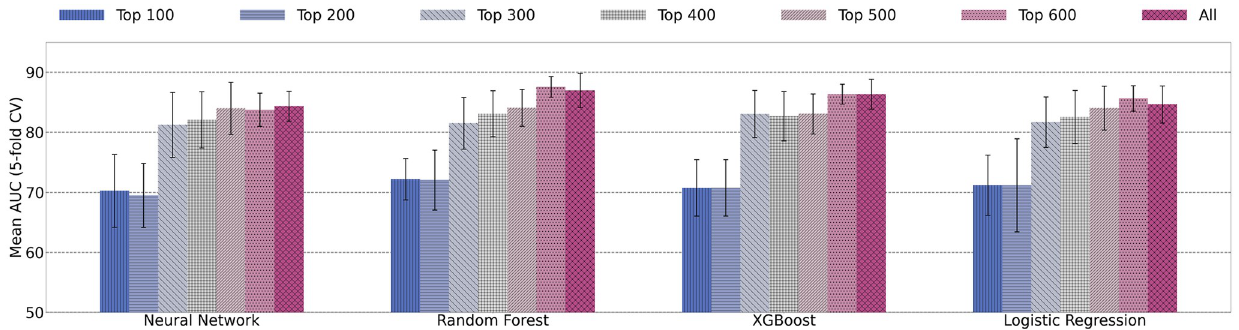
Fig 14. Mean AUC values and standard deviation of ensemble models trained using increasing number of features.